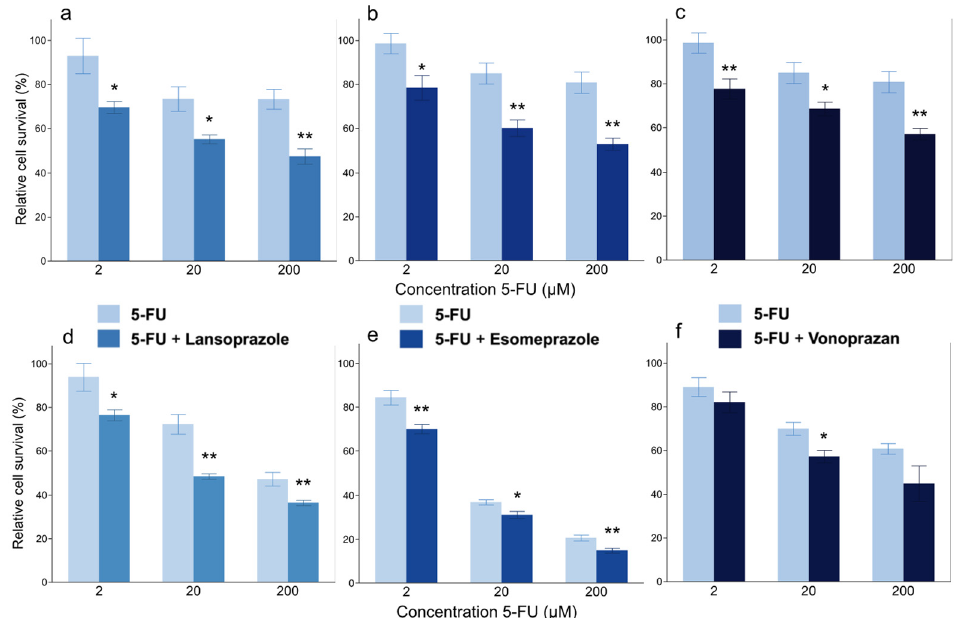
Figure 4. Effect of PPIs on the sensitivity of KYSE50 ( a – c ) and KYSE70 ( d – f ) cells to 5-FU. KYSE50 cells with ( a ) lansoprazole, ( b ) esomeprazole and ( c ) vonoprazan. KYSE70 cells with ( d ) lansoprazole, ( e ) esomeprazole and ( f ) vonoprazan. *: p < 0.05, **: p < 0.01.